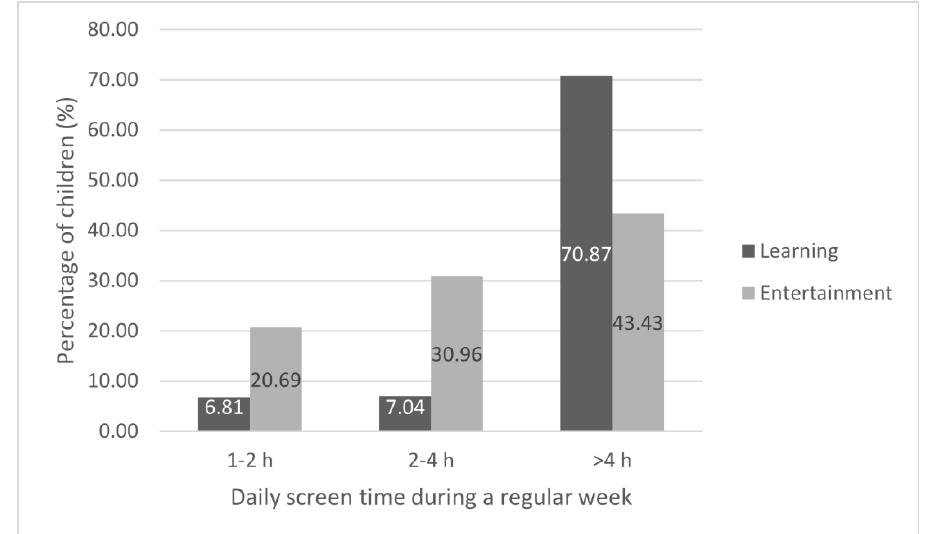
Figure 1. Screen time exposure during a regular weekday. Answers of parents who denied that their children were using digital devices for educational (15.20%) or recreational (4.92%) purposes are not presented.